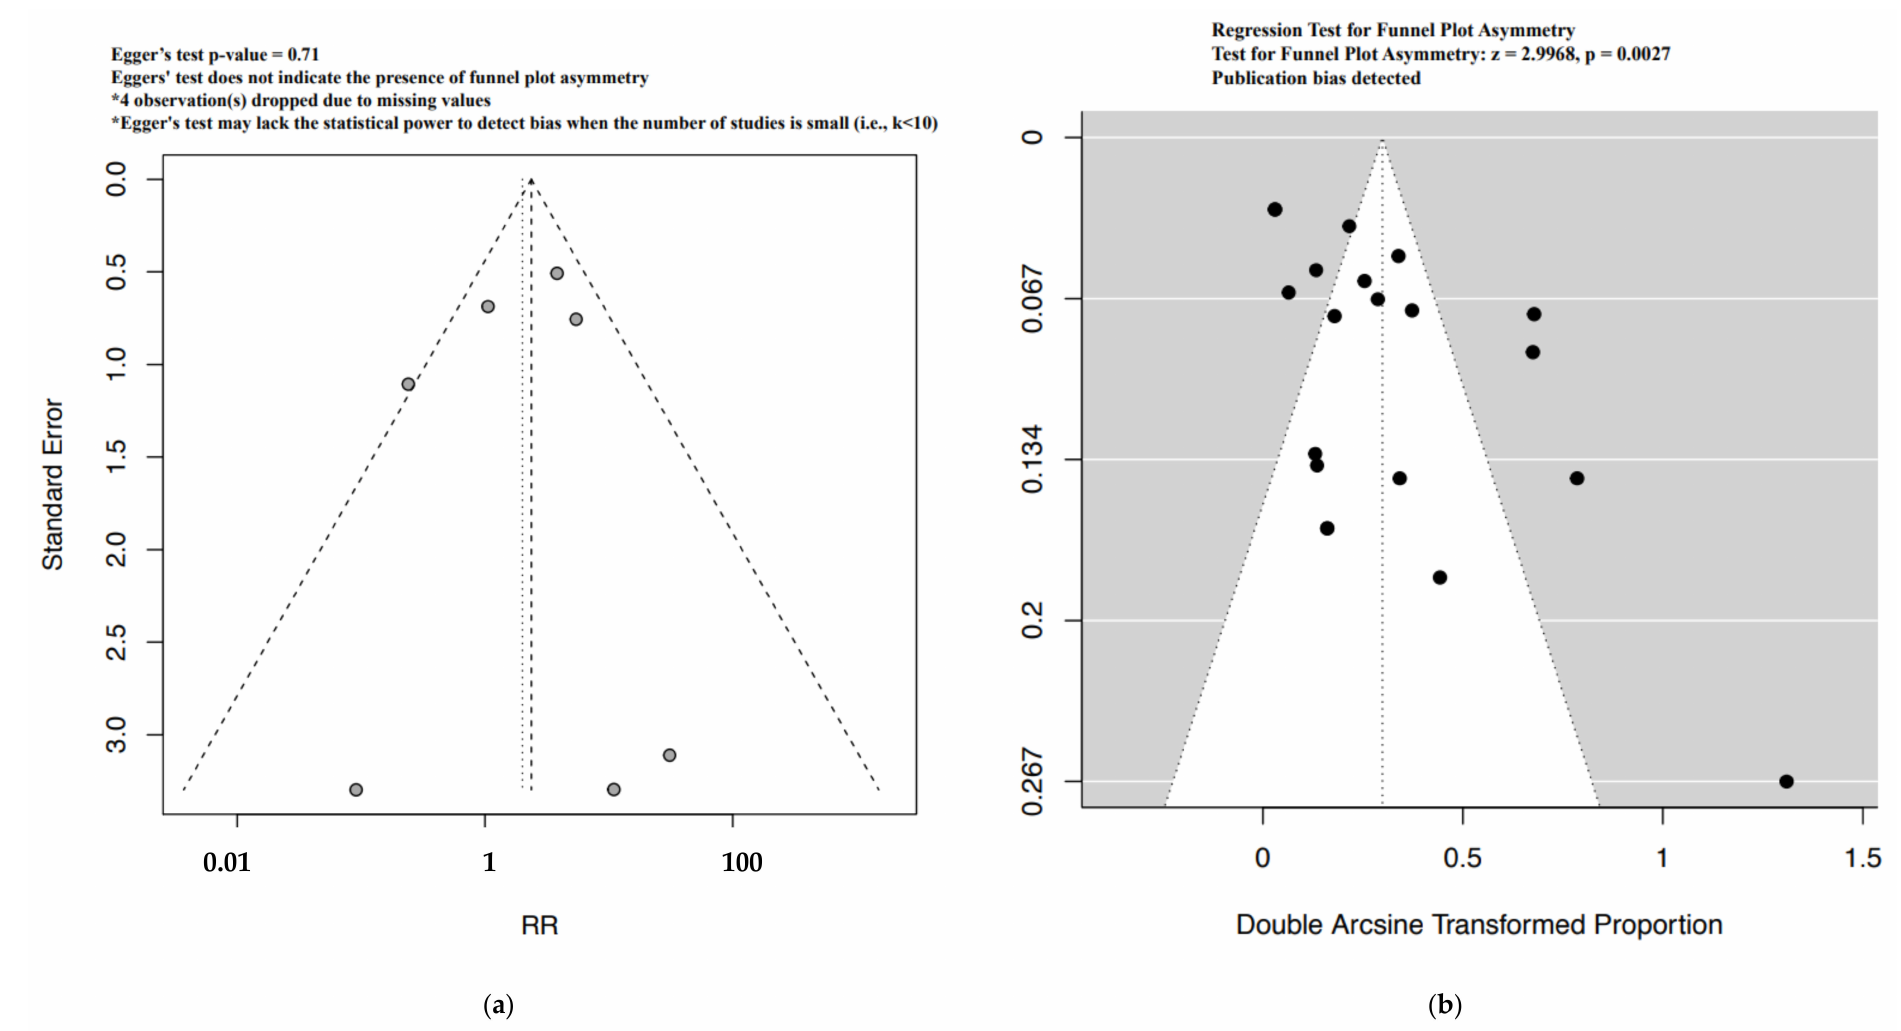
Figure 2. Funnel plots bradycardia—RCT ( a ) and proportion based meta-analysis ( b